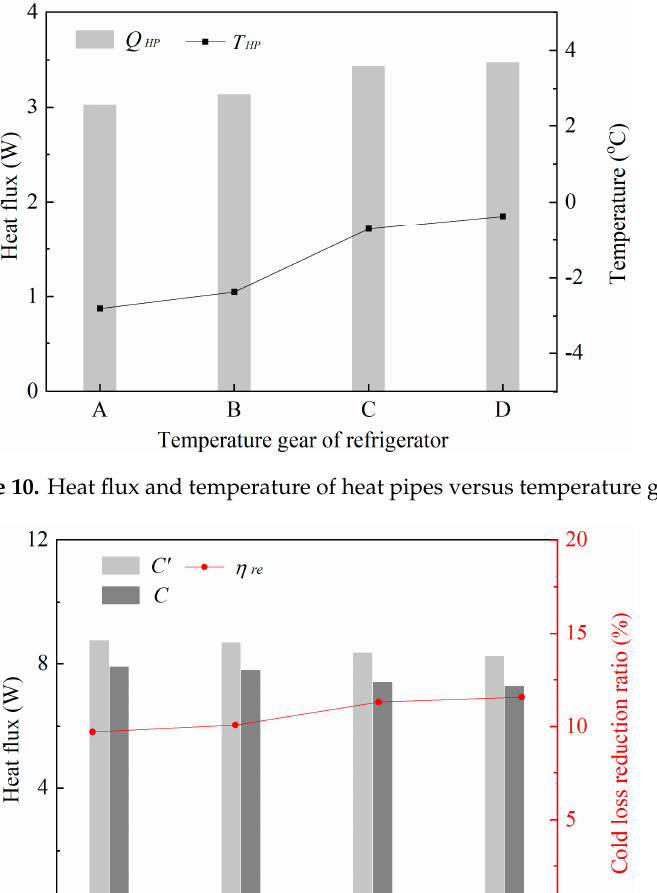
Figure 10. Heat flux and temperature of heat pipes versus temperature gear.